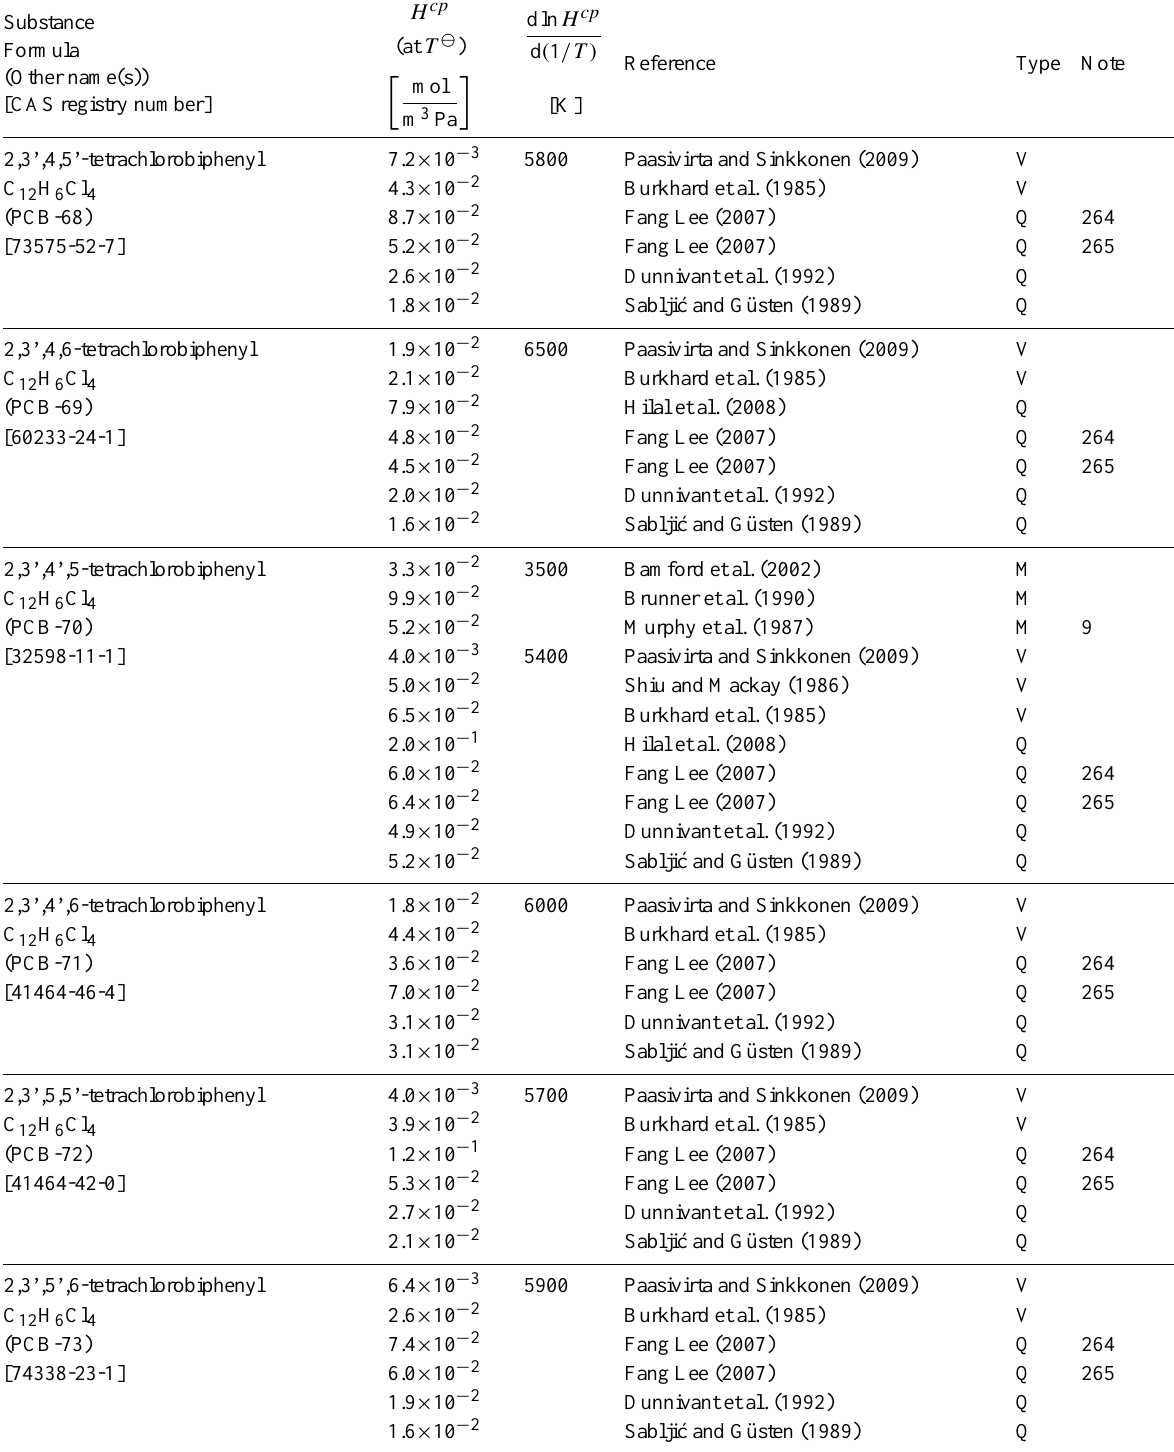
Table 6: Henry’s law constants for water as solvent